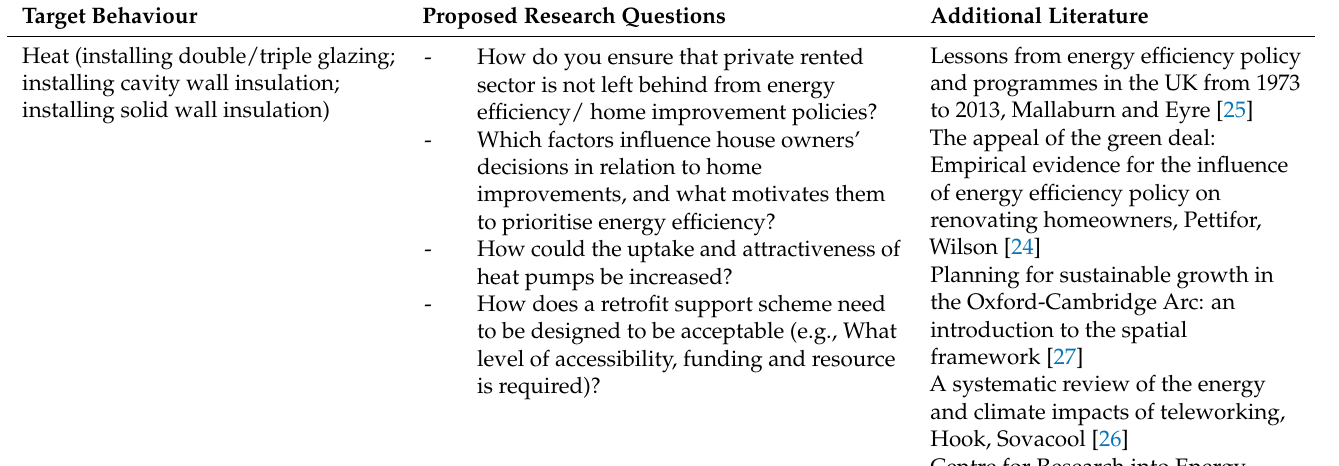
Table 5. Future research ideas relating to prioritised target behaviours proposed by the expert panel during the final discussion session of the